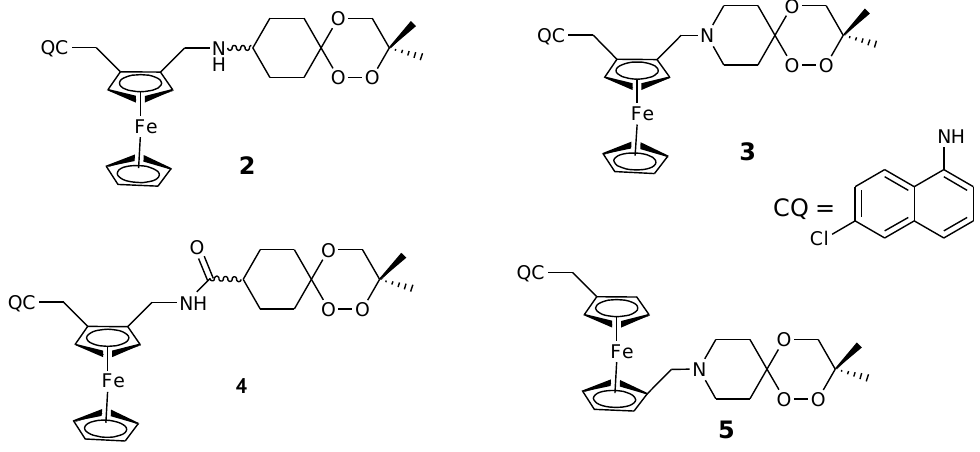
Figure 3. Chemical structures of trioxaferroquine derivatives ( 2 – 5 ).